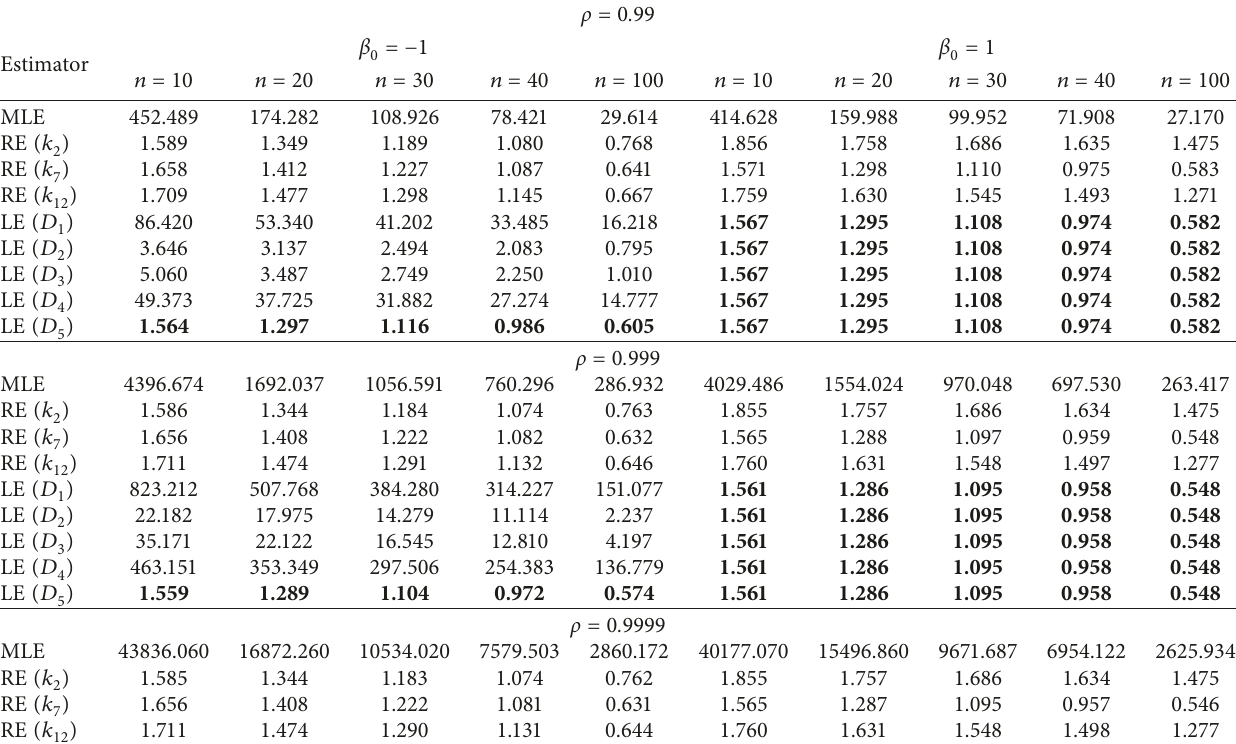
Table 3: Estimated SMSE values for different n, ρ ,k, d, and β